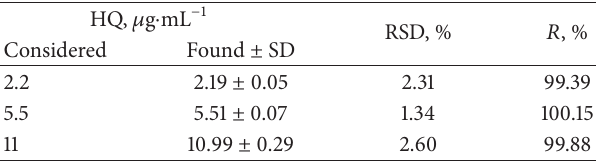
Table 3: The precision and accuracy of the results obtained by the proposed spectrometric method; 𝑛 - number of independent measurements; 𝑛 = 5 ; SD: standard